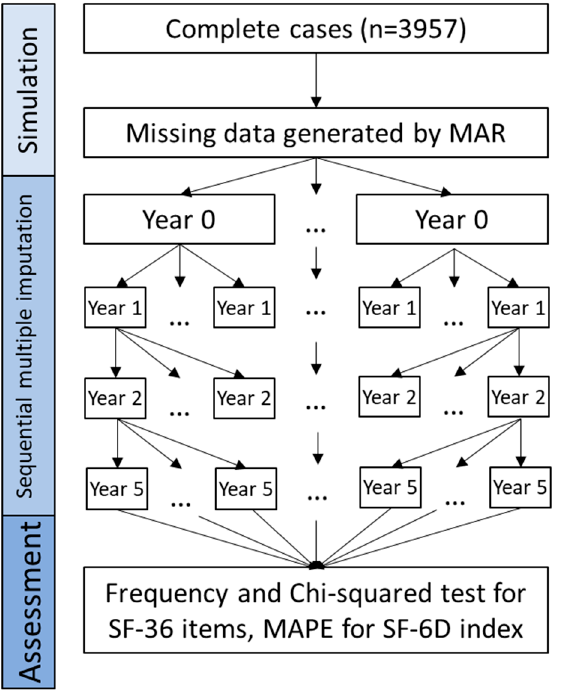
Figure 5. Flowchart of simulation, sequential multiple imputation, and assessment. MAPE, mean absolute percentage error.